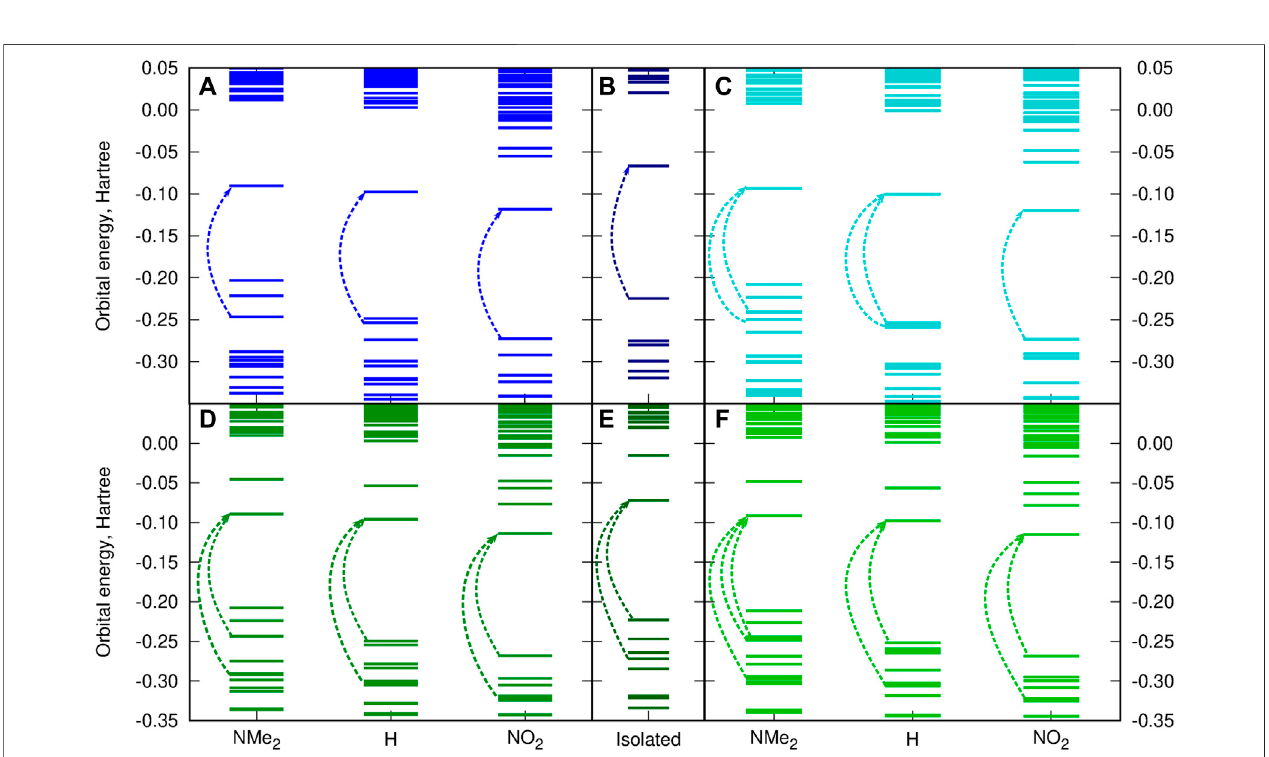
FIGURE11| Substitution effectontheorbital energy levels [CAM-B3LYP/6-31+G(d)] fortheinvestigatedsystemsincomparison totheisolated (thio)squaraine (A) OSQ-DPU, (B) isolated OSQ, (C) OSQ-DPTU, (D) SSQ-DPU, (E) isolated SSQ, and (F) SSQ-DPTU (dashed arrows indicate orbitals involved in most intensive long- wavelength